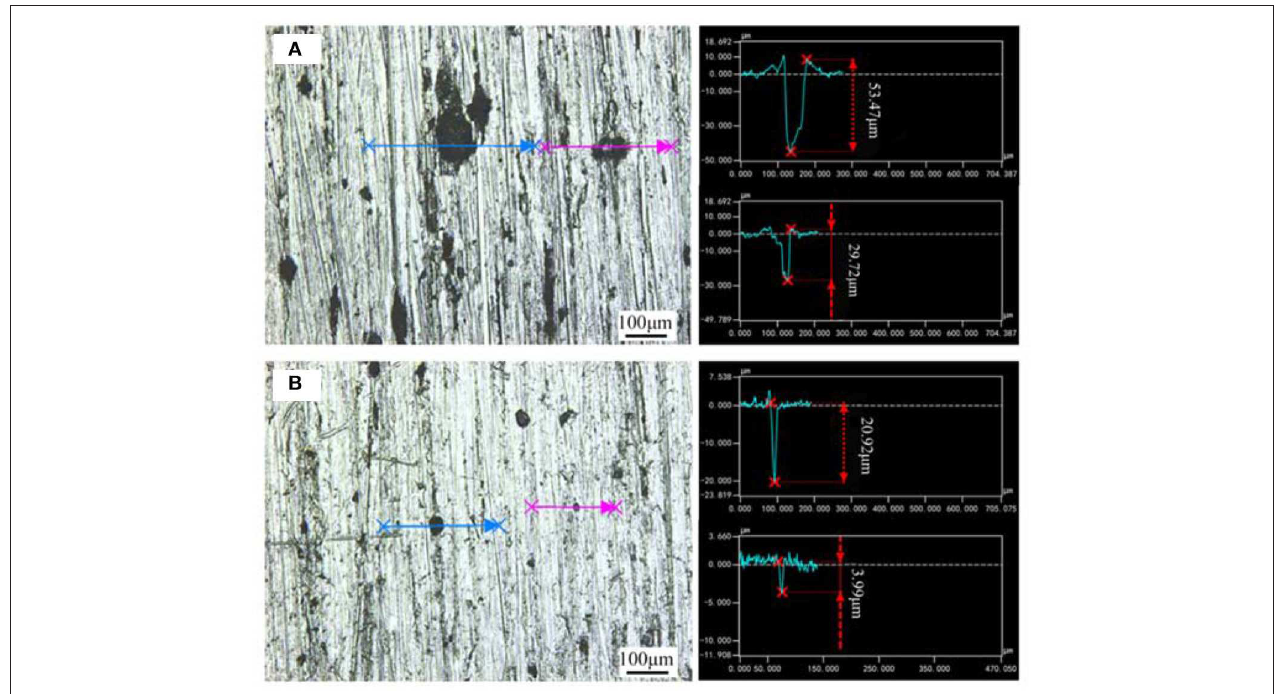
FIGURE 5 | Microscopic morphologies and the corresponding pit depth of (A) Bare sample; (B) Pre-passivated sample after the rust removal.